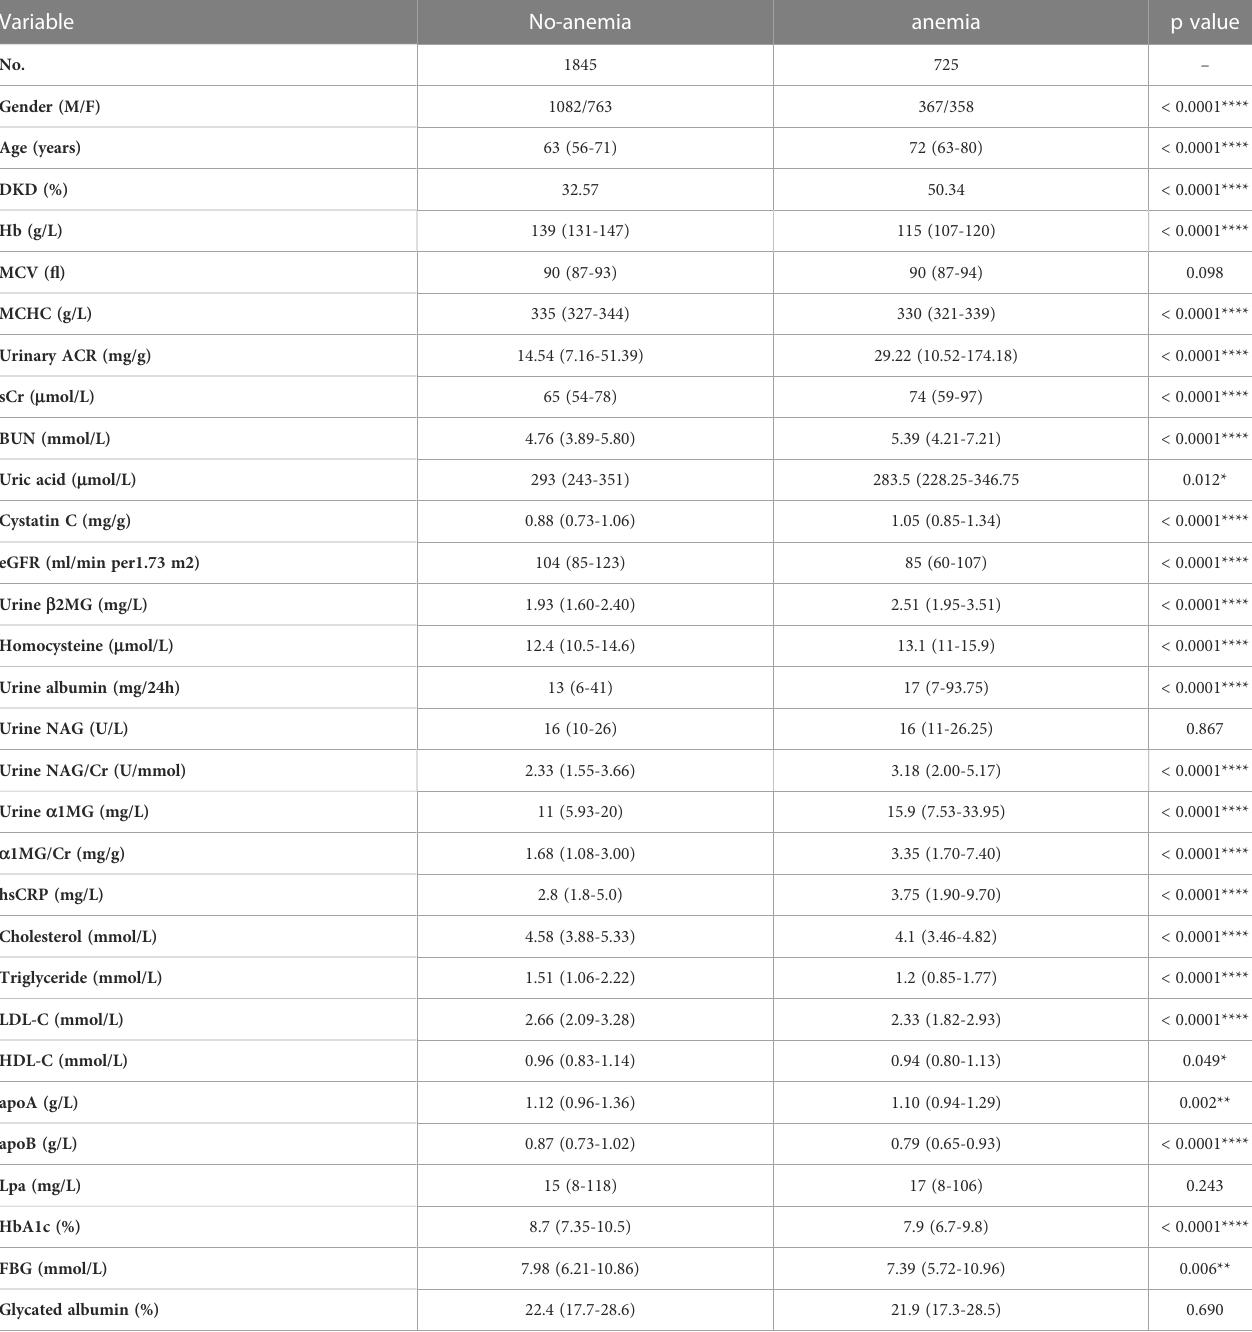
TABLE 2 Clinical characteristics of type 2 diabetic patients with or without